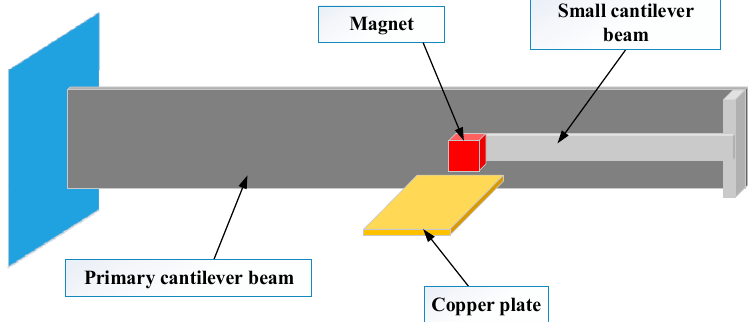
Figure 1. A cantilever beam controlled by an eddy current tuned mass damper (ECTMD).